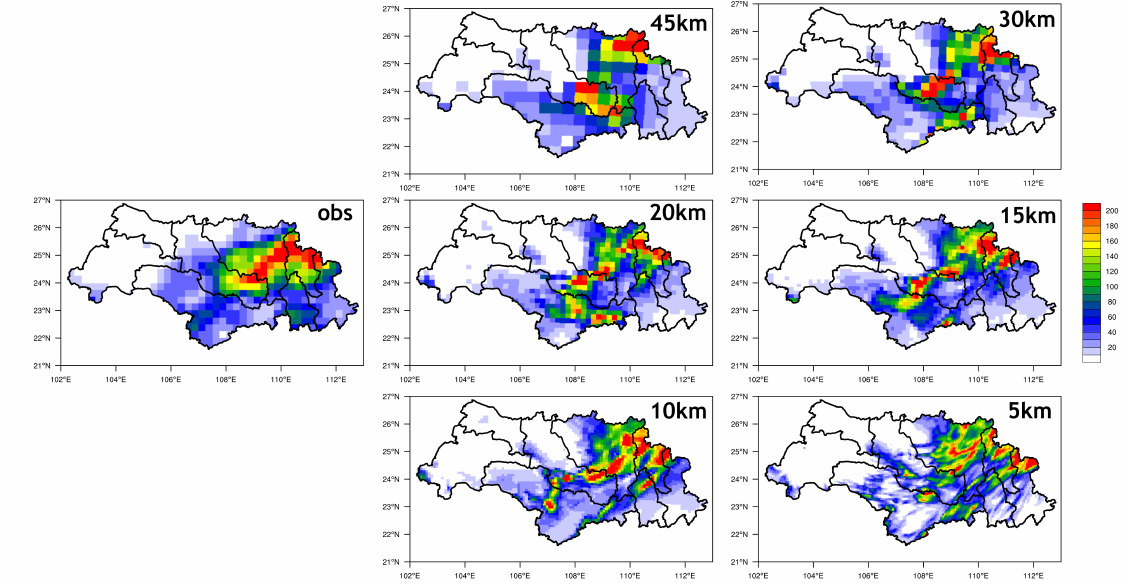
Figure 5. Study region maps showing the observed and simulated precipitation (mm) distribution at different horizontal resolutions for Case